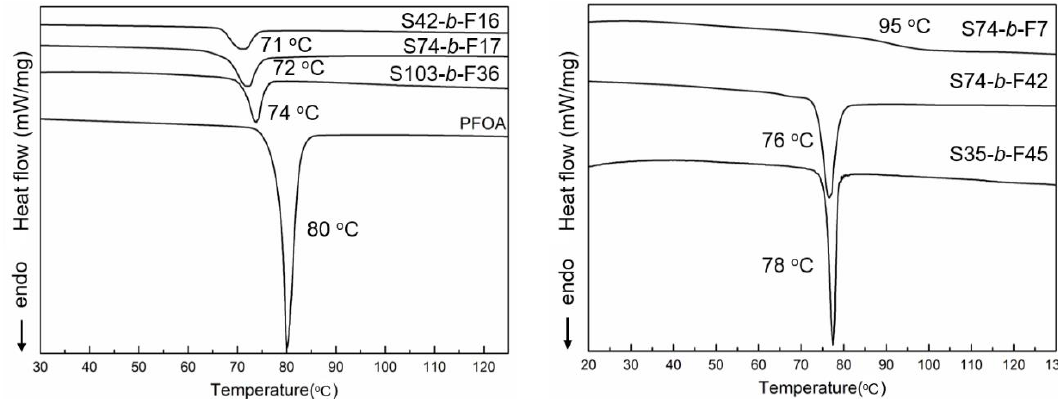
Figure 1. Di ff erential scanning calorimetry (DSC) curves of S- b -F block polymer and perfluorooctylethyl Figure 1. Differential scanning calorimetry (DSC) curves of S- b -F block polymer and acrylate (PFOA) perfluorooctylethyl acrylate (PFOA) homopolymer.